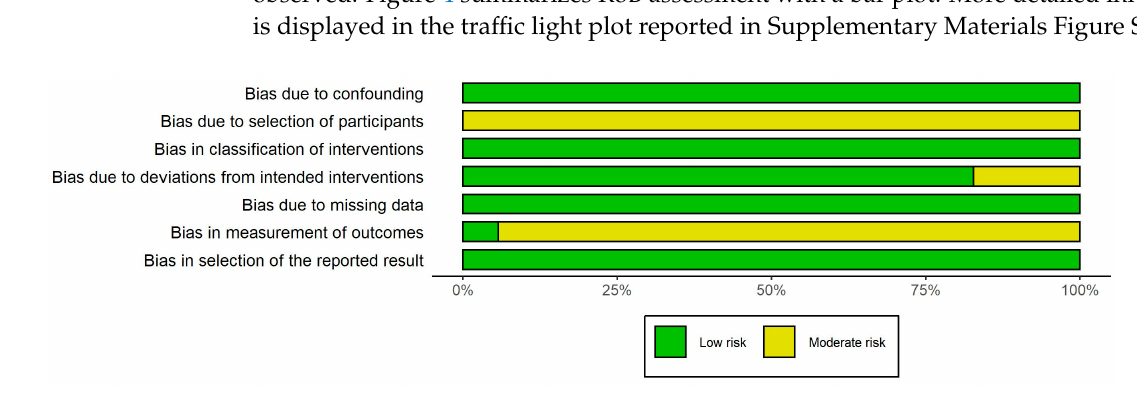
Figure 4. Risk of bias assessment summarized in a bar plot.